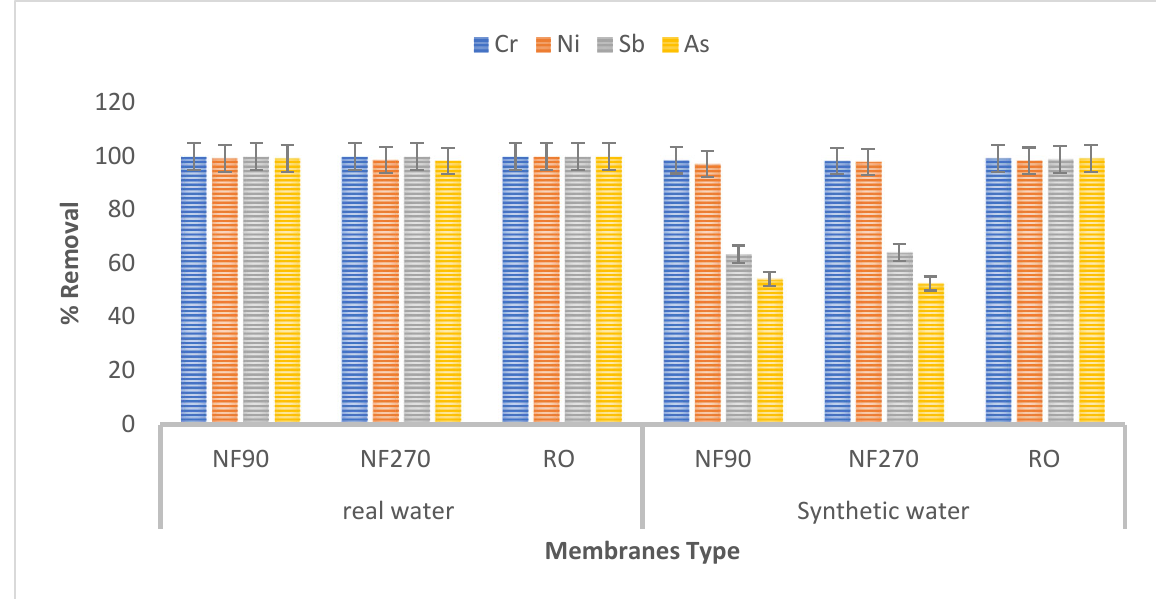
Figure 5. Comparison of % removal between synthetic waters and real water.